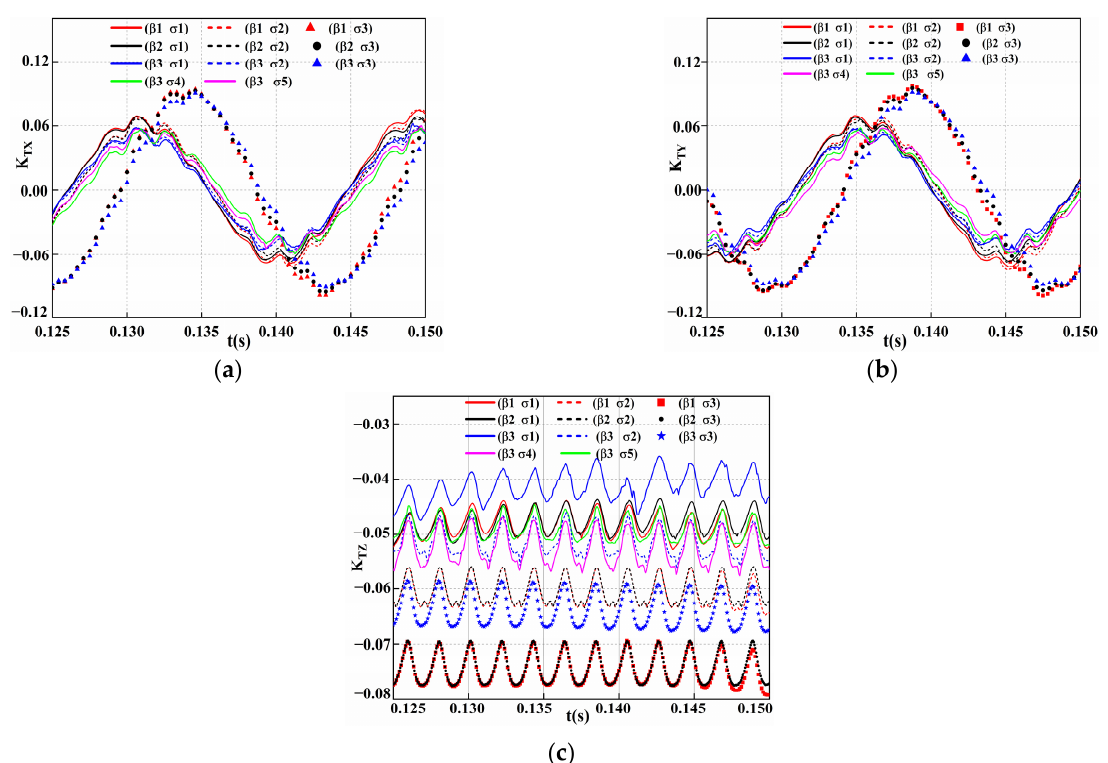
Figure 16. Bearing force of the single-blade at different oblique angles and cavitation numbers. ( a ) Difference of K TX ; ( b ) Difference of K TY ; ( c ) Difference of K TZ